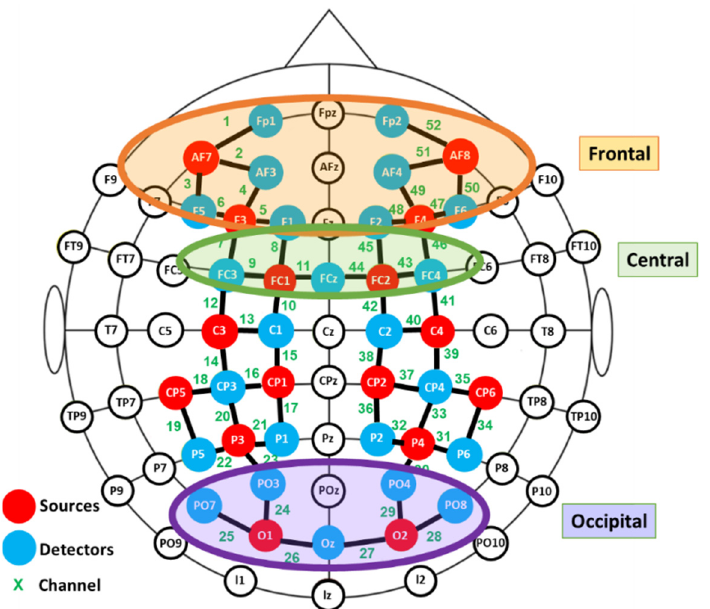
Figure 2. Functional near infrared spectroscopy ( fNIRS) montage. Signal acquisition was made by the colored optodes.